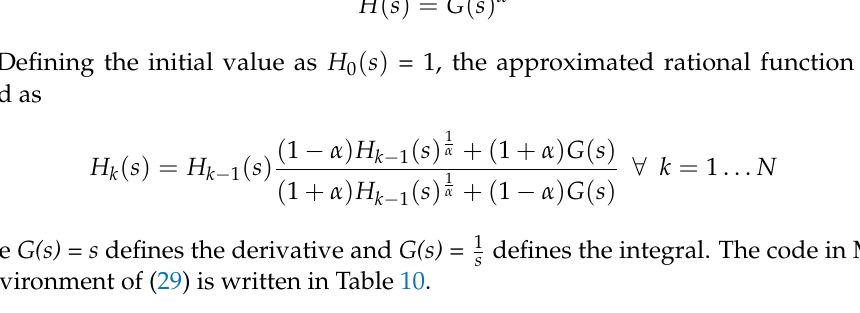
Table 10. Code in Maple 18 environment of